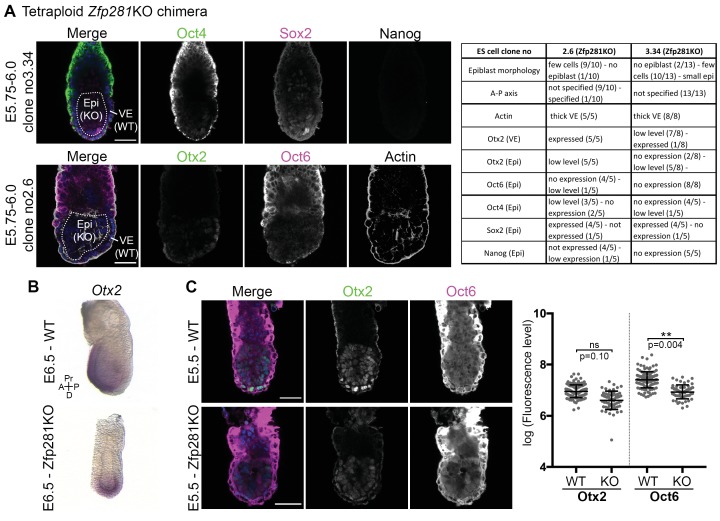
Expression of pluripotency markers in tetraploid chimera and early postimplantation WT and Zfp281KO embryos.(A) Immunohistochemistry of pluripotency factors Oct4, Sox2, Nanog, Otx2 and Oct6 in tetraploid chimera where the epiblast contains Zfp281KO cells and VE cells are WT. Table summarizes the results for each stain of two independent ESC clones. Note that Nanog is not expressed at this stage. (B) Wholemount in situ hybridization (WISH) analysis of Otx2 reveals expression at the anterior of a WT embryo. In Zfp281KO embryos, Otx2 is expressed at the distal tip. A = Anterior, p=Posterior, Pr = Proximal, D = Distal. (C) Immunofluorescence of Otx2 and Oct6 proteins in WT and Zfp281KO embryos at early post-implantation stage (E5.5) and Fluorescent intensity quantification of Otx2 and Oct6 proteins nuclear levels (each dot representing the log-transformed mean corrected fluorescence level per epiblast cell) using Imaris software. For WT, n = 3 embryos and for Zfp281KO, n = 2 embryos (30 cells quantified per embryo). Statistical significance was calculated on the average level of corrected fluorescence per embryo using Student T-test. Scale bars represent 50 µm.